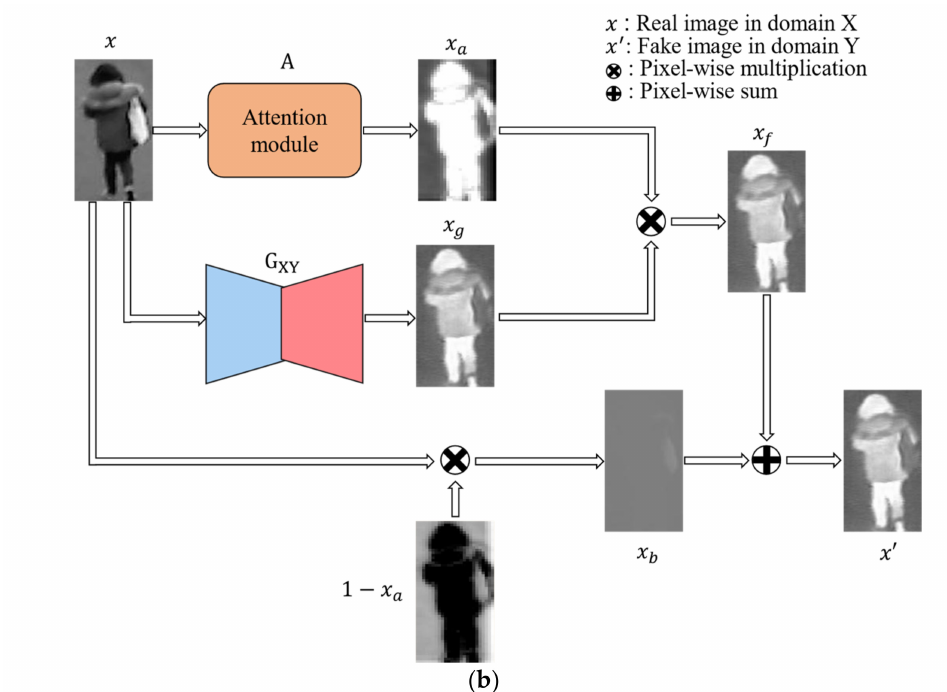
Figure 2. SI-AGAN structure. ( a ) Overall architecture of SI-AGAN. ( b ) Detailed architecture of the black dashed rectangle in ( a ), which includes the attention